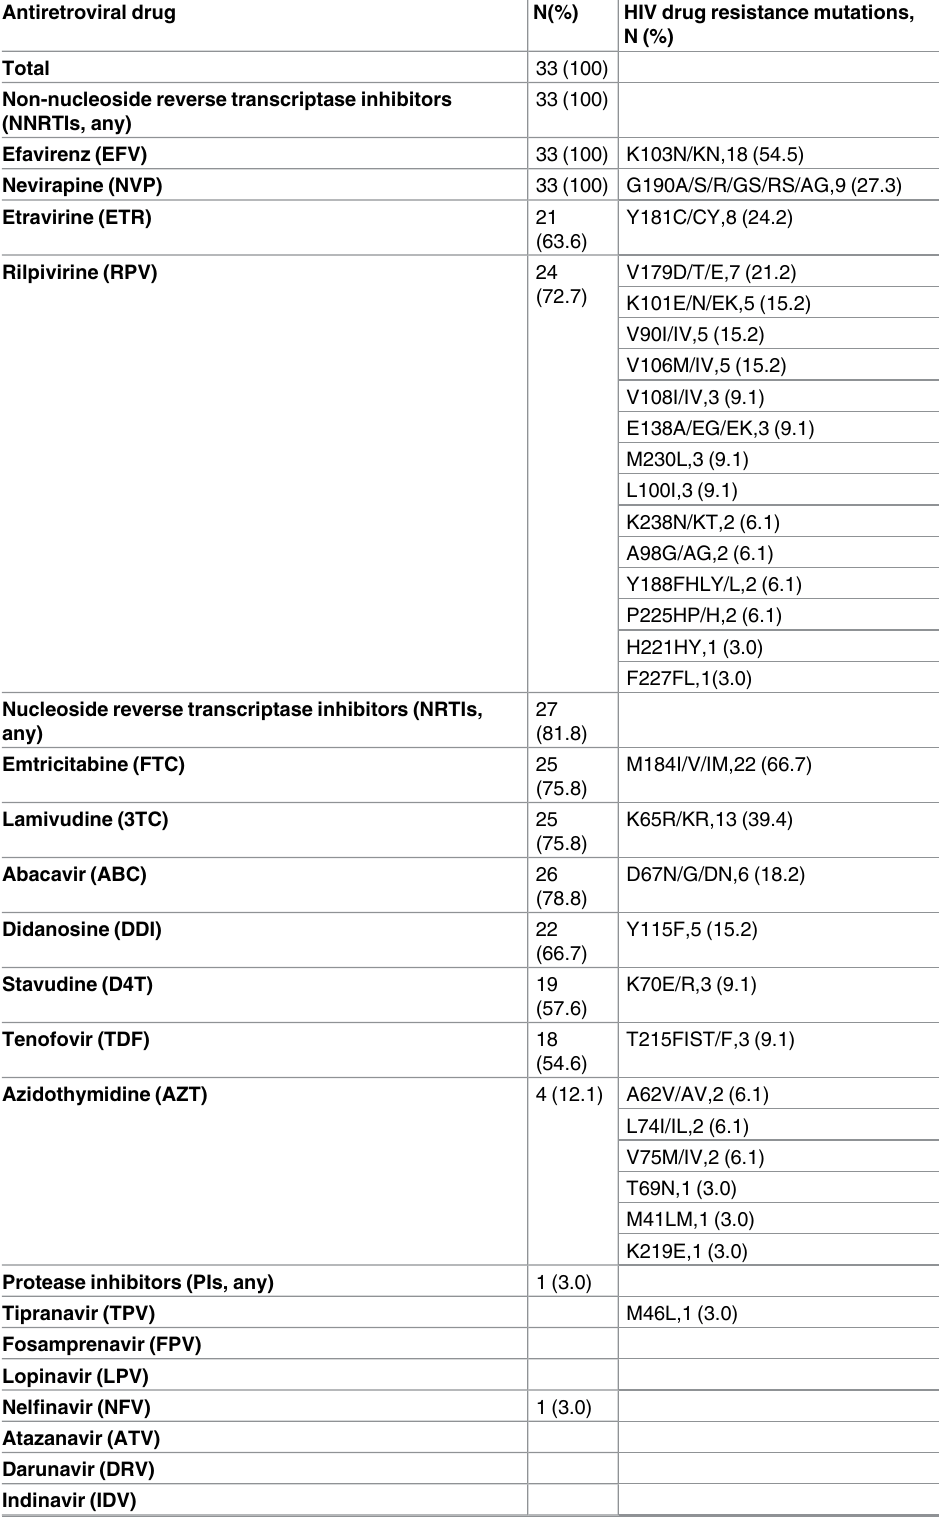
Table 2. HIV drug resistance mutations among HIV patients with drug